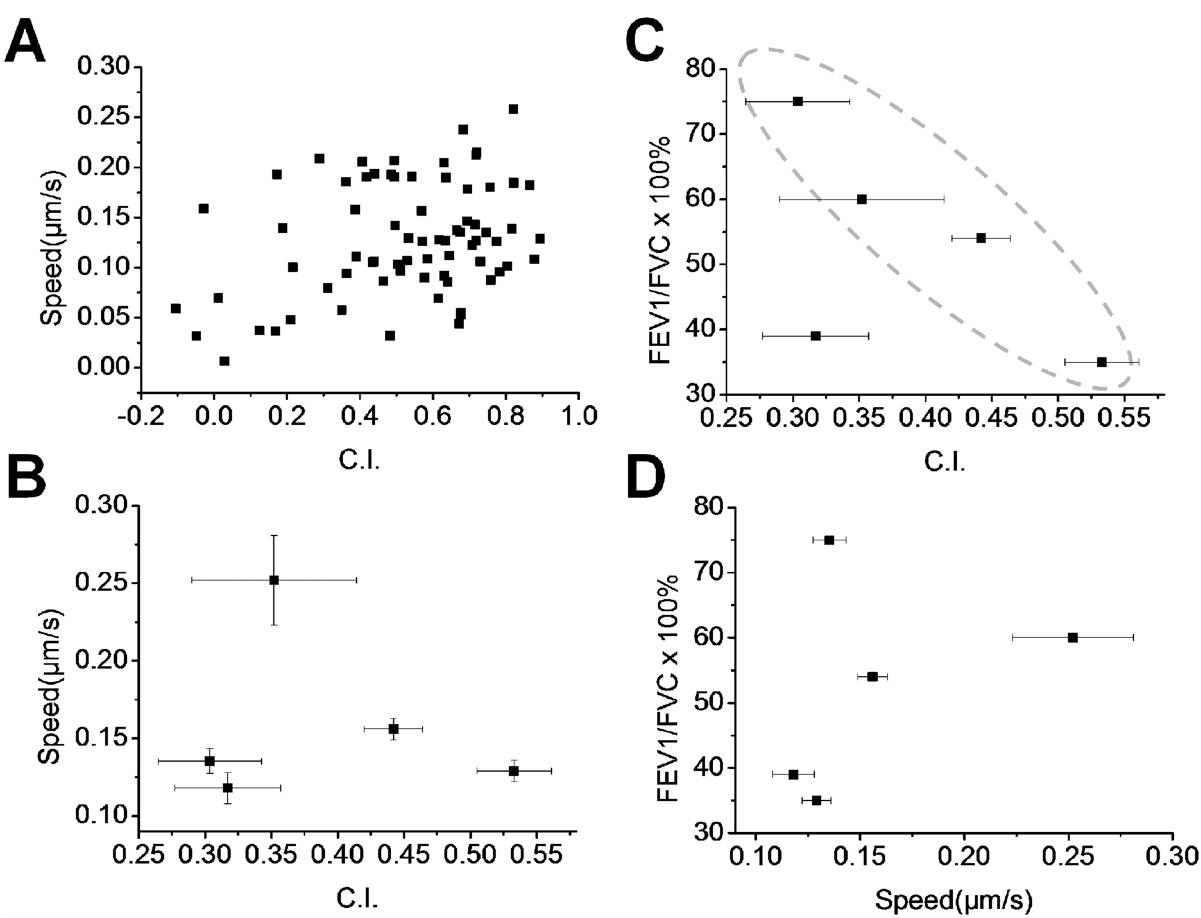
Fig 4. Correlations between neutrophil chemotaxis parameters and spirometry data. (A) No correlation is found between C.I. and migration speed in COPD sputum gradient from a single representative experiment; (B) No correlation is found between C.I. and migration speed from different COPD sputum samples; (C) Correlation between C.I. and FEV1/FVC. The dashed ellipse highlights the data with significant correlation; (D) No correlation is found between the migration speed and FEV1/FVC. The error bars indicate